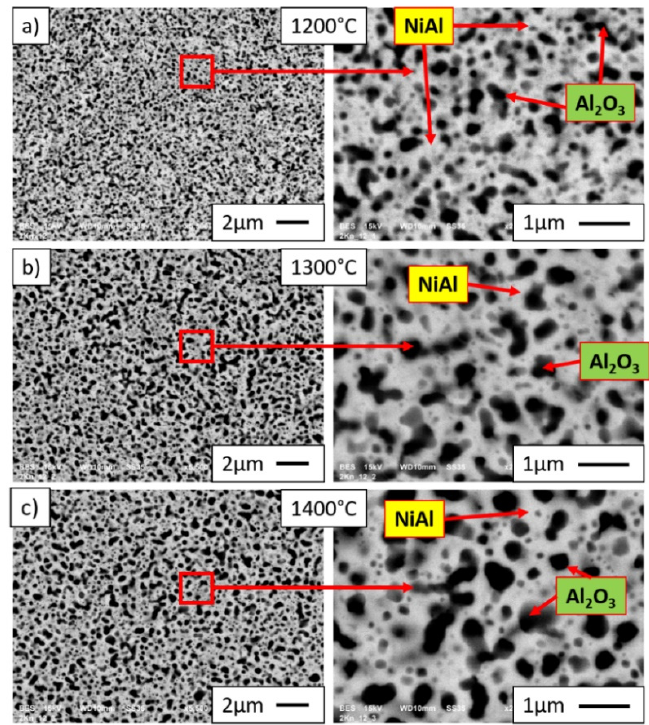
Figure 12. SEM images of microstructures of NiAl-20%Al 2 O 3 samples after sintering by PPS at ( a ) 1200 °C, ( b ) 1300 °C, and ( c ) 1400 °C.